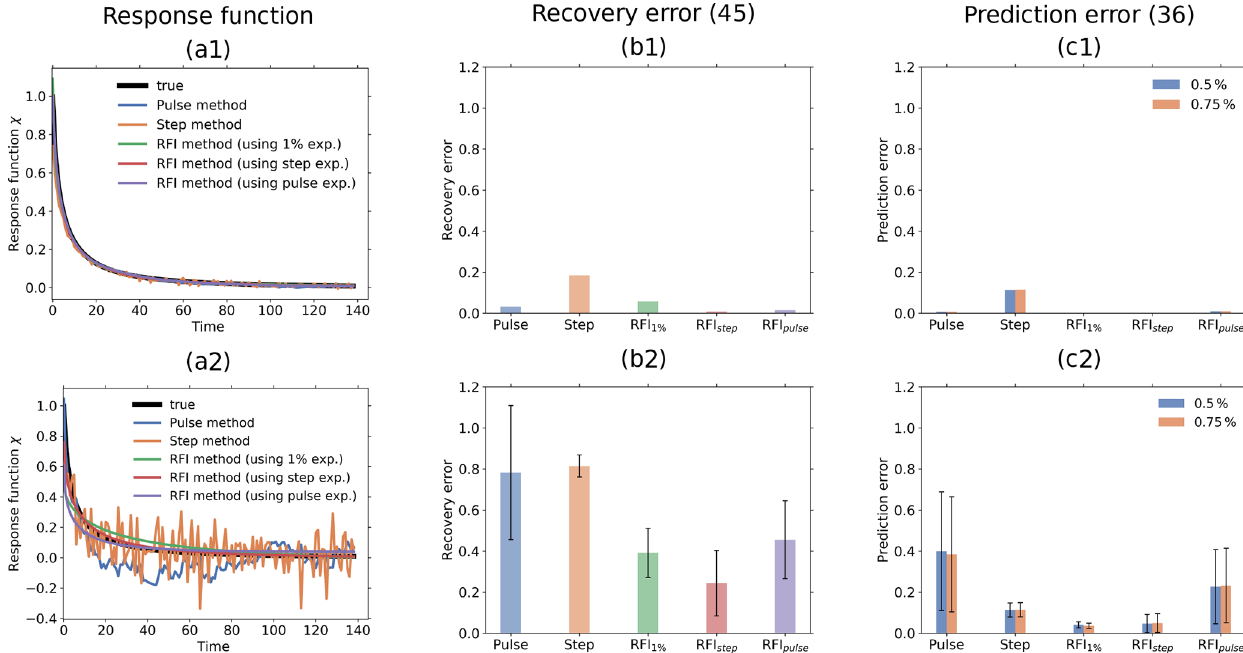
Figure 9. Quality of response function recovery by the full RFI method (including step 6 in Fig. 1) in comparison to the pulse and step method. Subscripts at “RFI” indicate the experiment from which the response function was recovered with the RFI method. First row: taking the average over the whole ensemble of toy model experiments for recovery; second row: performing the recovery for each ensemble member separately. ( a 1 ) Recovered response function; ( b 1 ) recovery error; ( c 1 ) prediction error (Eq. 36); ( a 2 ) example of recovered response function from one ensemble member; ( b 2 ) statistics of recovery error; ( c 2 ) statistics of prediction error (Eq. 36). The prediction error is separately computed for the 0.5% and 0.75% experiments. Taking the ensemble average, all methods perform well (see first row). However, taking only one ensemble member, the RFI algorithm gives better recovery and prediction errors than the pulse and step methods when comparing the same responses (see second